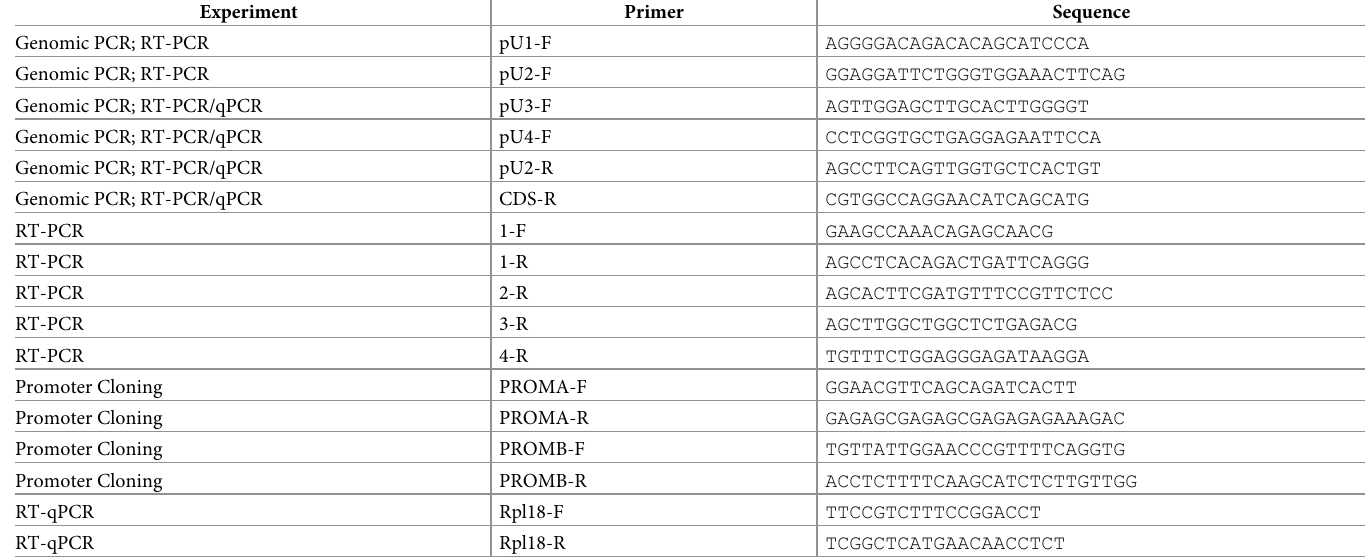
Table 1. PCR primers used in this